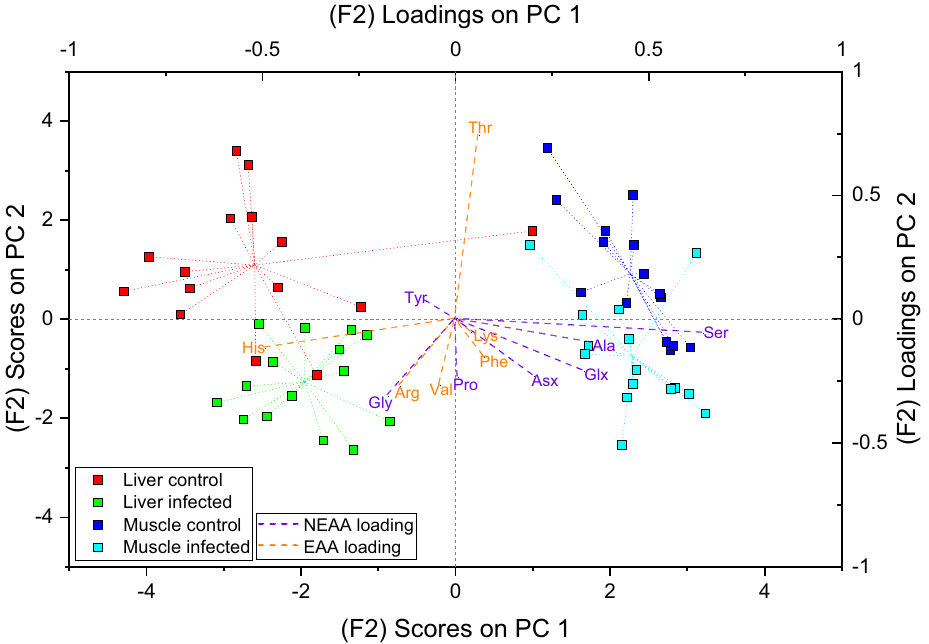
Figure 2. Multivariate analysis of Δδ 13 C Fish-Diet values shows higher trophic fractionation of most individual AAs in liver and muscle tissue of infected sticklebacks compared to uninfected control individuals on the same diet. PC1 of the first factor (tissue) from ASCA analysis separates muscle and liver tissue of the infected and control individuals, whereas PC2 shows separate clusters of infected and control liver and muscle